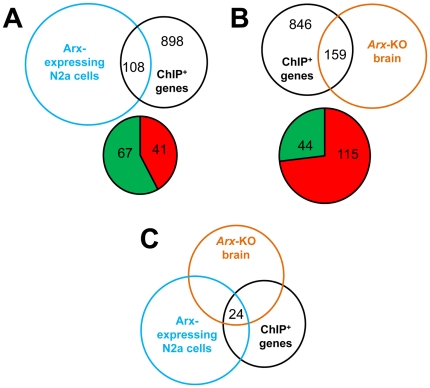
Gene expression changes of Arx candidate targets.A) Venn diagram illustrating the number of ChIP-positive genes that were found to show expression changes in Arx-overexpressing cells. The Pie diagram shows the number of ChIP-positive genes that are down-regulated (indicated in green) or up-regulated (indicated in red). B) Venn diagram illustrating the number of ChIP-positive genes that were found to show expression changes in Arx knock-out ventral forebrain. The Pie diagram shows the number of ChIP-positive genes that are down-regulated (indicated in green) or up-regulated (indicated in red). C) Venn diagram illustrating the number of ChIP-positive genes that show gene expression changes in both Arx-overexpressing cells and Arx knock-out mice.